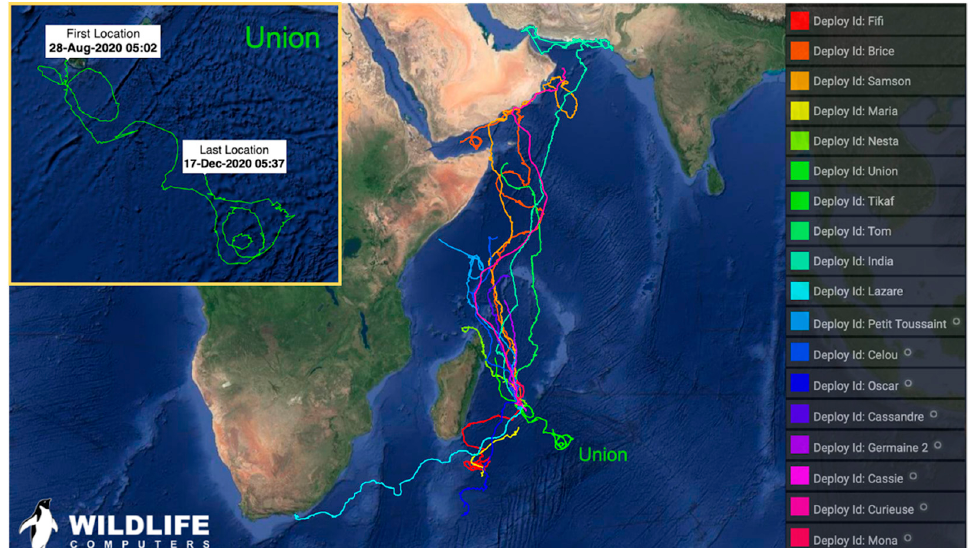
Figure 9. Trajectories and names of the 18 loggerheads and Olive Ridley STs equipped with Wildlife Computers SPLASH10 tags released from Réunion’s Island as of 10 March 2021. Circles next to the ST names on the right-hand side indicate active tags as of 20 March 2021. The insert on the left-hand side shows a zoomed view of ST Union trajectory between 28 August and 17 December 2020. Four additional animals, equipped with LOTEK Kiwisat tags, were also released from Réunion island in 2019 (not shown). Plots are extracted from Wildlife Computers’ real-time ARGOS tracking platform.